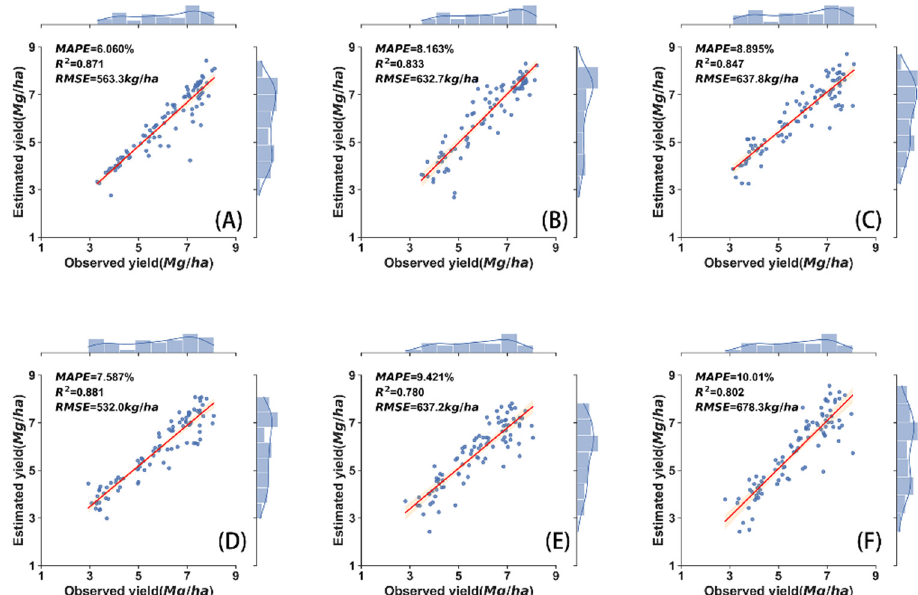
Figure 5. Comparison of yield estimation results for LSTM models based on different time steps: